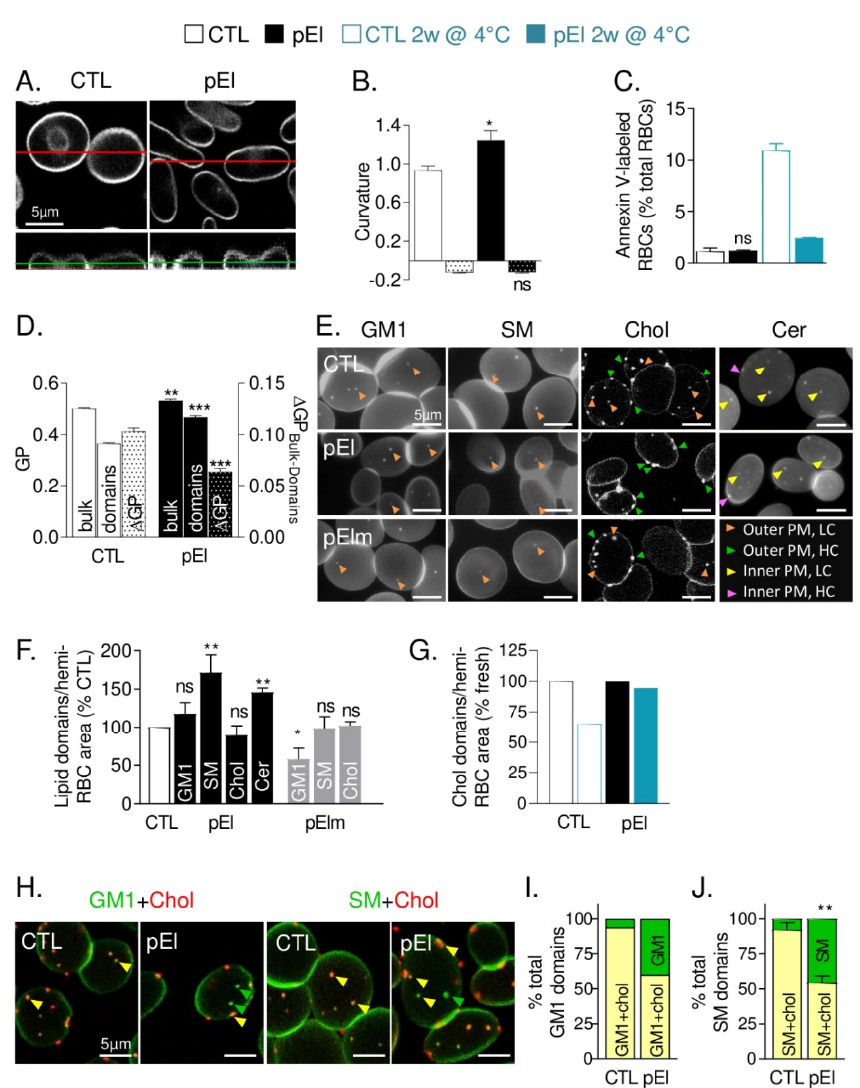
Figure 3. The RBC membrane from patient pEl exhibited increased curvature in high curvature areas, enhanced rigidity, impaired low curvature-associated lipid domains but preserved transversal asymmetry. ( A , B ) Membrane curvature. ( A ) RBCs were labeled with BODIPY-GM1, laid down in IBIDI chambers and analyzed by vital confocal microscopy. The figure shows in upper panels X-Y sections (positions indicated by the green lines in the lower panels) and in lower panels the corresponding X-Z sections (positions indicated by the red lines in the upper panels). Images are representative of 2 independent experiments. ( B ) RBCs were laid down in IBIDI chambers and analyzed in side view for membrane curvature profiles. The highest and lowest curvatures of each membrane curvature profile were then determined (open and dotted columns, respectively). Data are representative of 5 independent experiments with 6–16 RBCs analyzed per experiment. Unpaired t tests to compare CTL vs. pEl in high curvature areas and CTL vs. pEl in low curvature areas. ( C ) Membrane asymmetry. Surface exposition of phosphatidylserine (PS) evaluated by flow cytometry with Annexin V-FITC on fresh or 2-week-old RBCs. Data are means ± SD/SEM of 2–3 independent